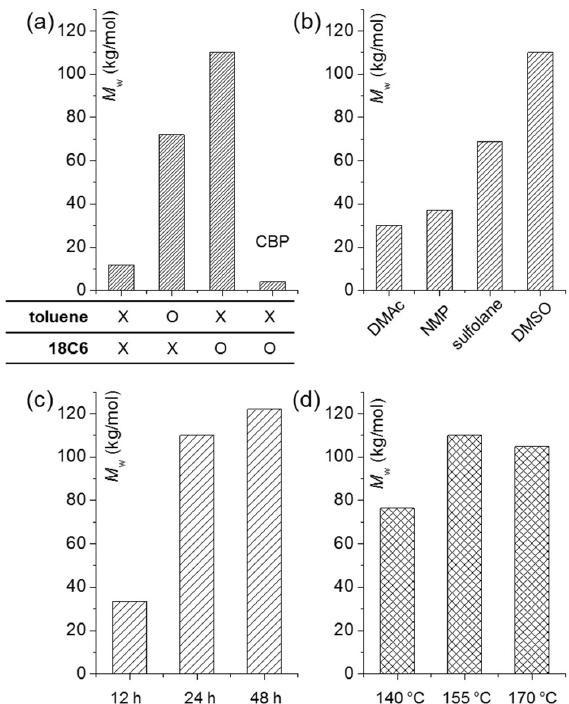
Figure 2. M w of polymers depending on various polymerization conditions including ( a ) additives (CBP instead of FBP in the last column), and polymerization ( b ) solvent, ( c ) time, and ( d ) temperature.